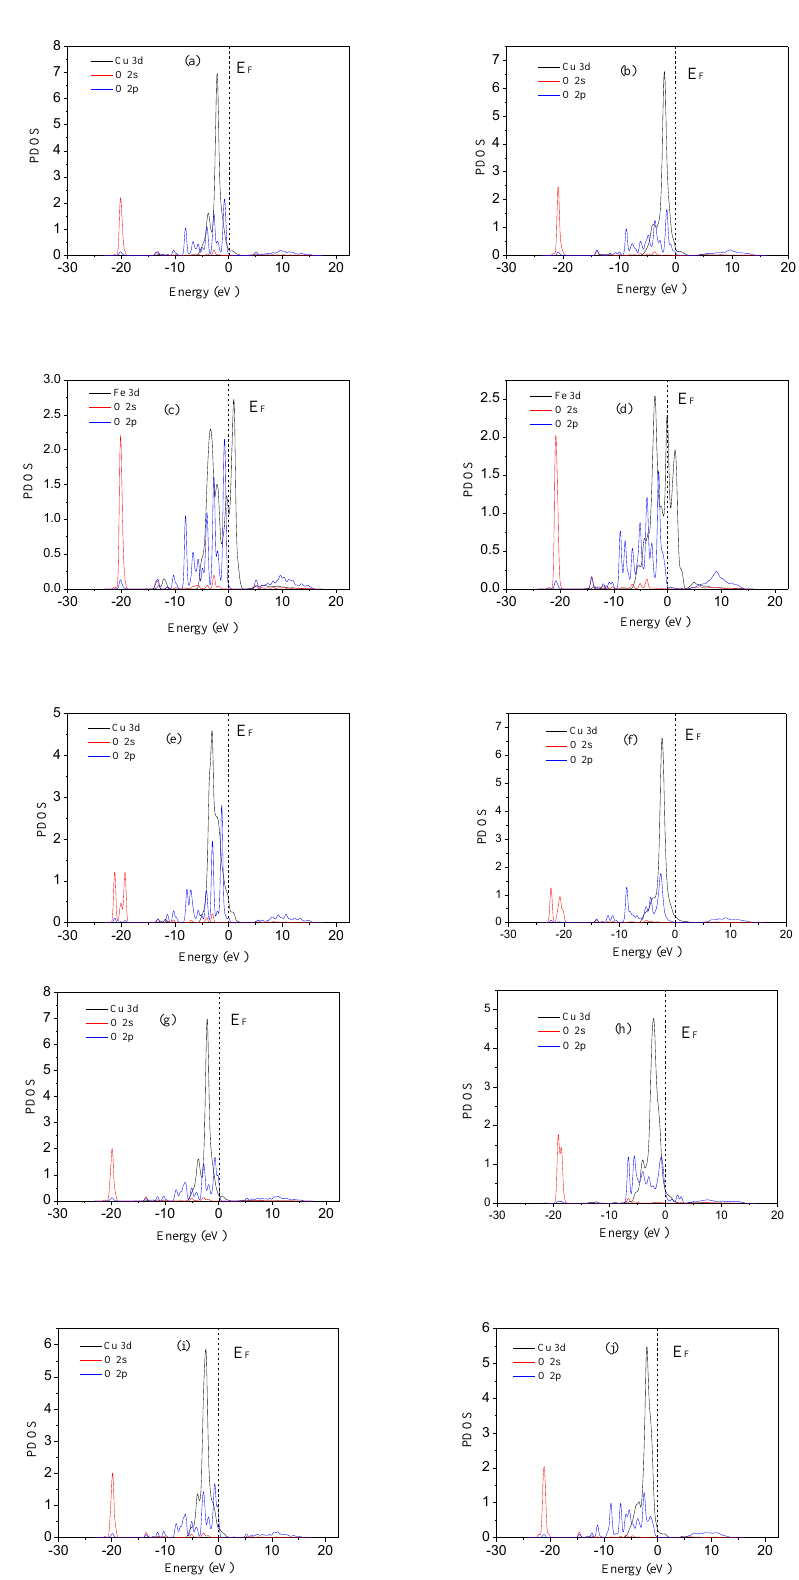
Figure 8. PDOS of single hydroxyl adsorbing on the S-defect site ( a , b ), Cu-defect site ( c , d ); polyhydroxyl adsorbing on the hollow site ( e , f ), S-defect site ( g , h ), and Fe-defect site ( i , j ).